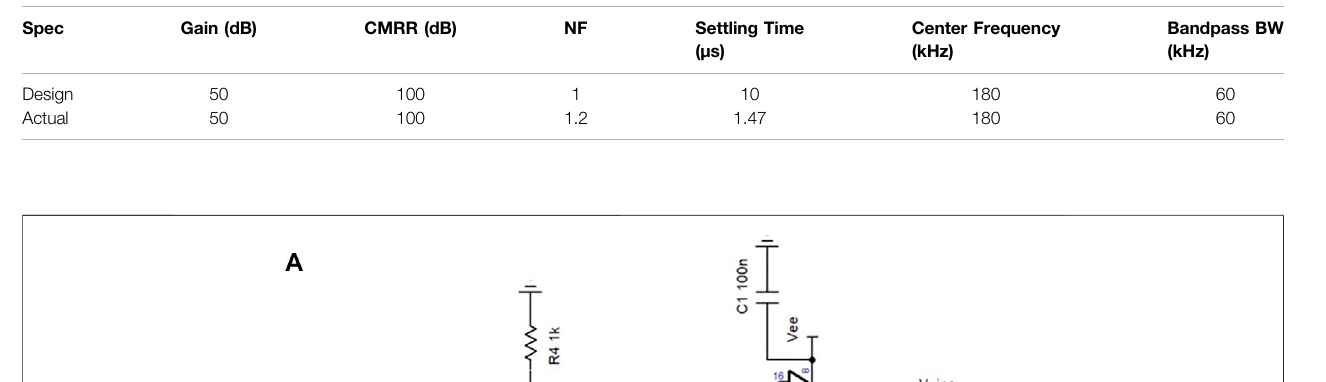
Frontiers in Physics |